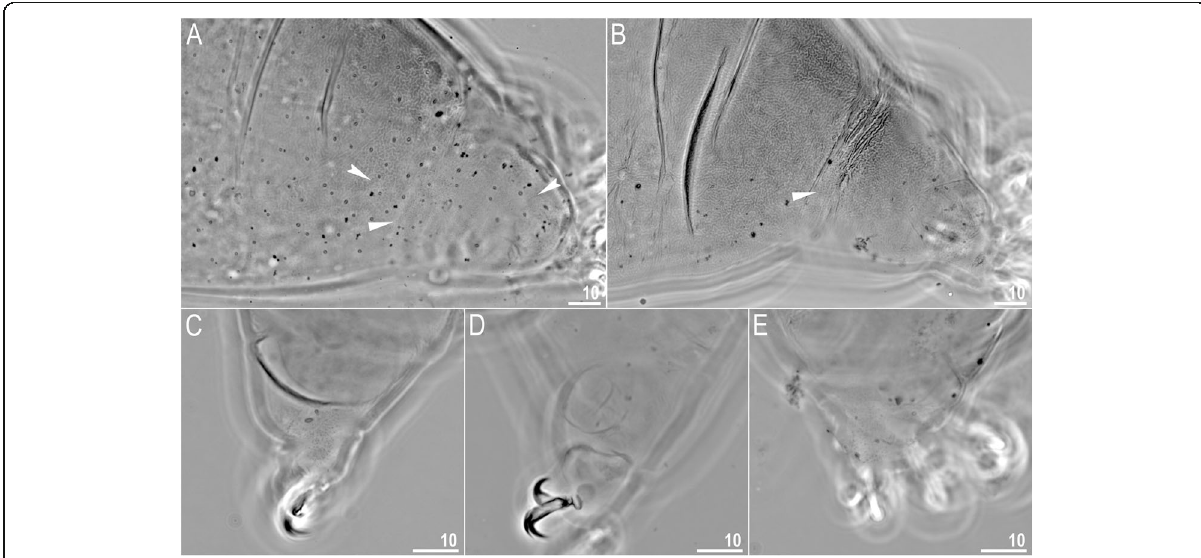
Fig. 13 Macrobiotus pseudopallarii sp. nov. from Montenegro (ME.007) – body and leg cuticle morphology seen with LCM: a – b – band of caudal granulation on the last body segment clearly visible in specimen with stretched cuticle ( a ) and hardly visible in specimen with wrinkled cuticle ( b ); c – granulation on the external surface of leg III; d – internal surface of leg III with evident pulvinus; e – granulation on dorsal surface of leg IV. Filled flat arrowheads indicate dense patches of granulation in the caudal band, filled indented arrowheads indicate sparse granulation in the caudal band. Scale bar in μ